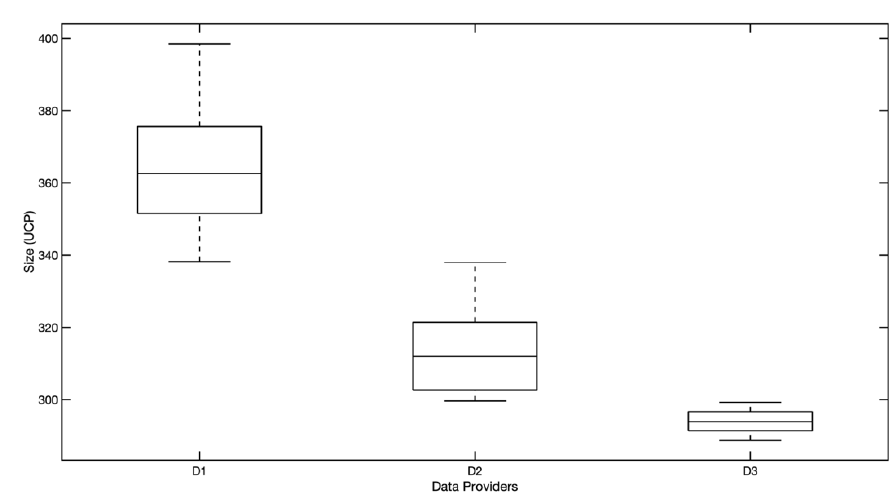
Figure 3. Distribution of size observation according to data provider.